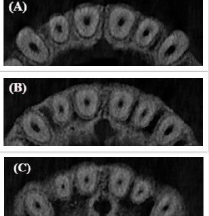
Figure 1. Unchanged cross-sectional root canal shape for maxillary anterior teeth (A) Coronal; (B) Middle; (C) Apical.